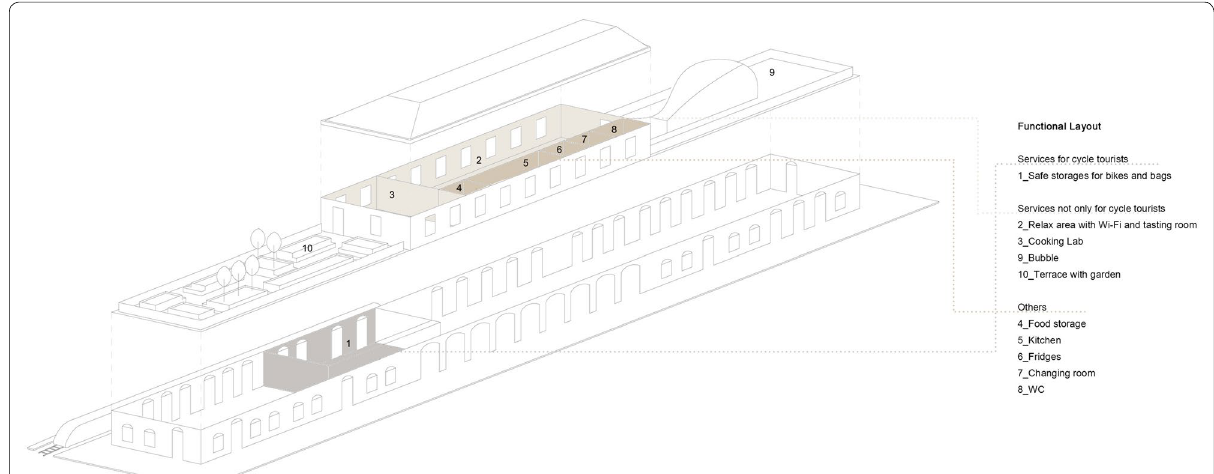
Fig. 11 Axonometric view of the functional layout of Tortona station project